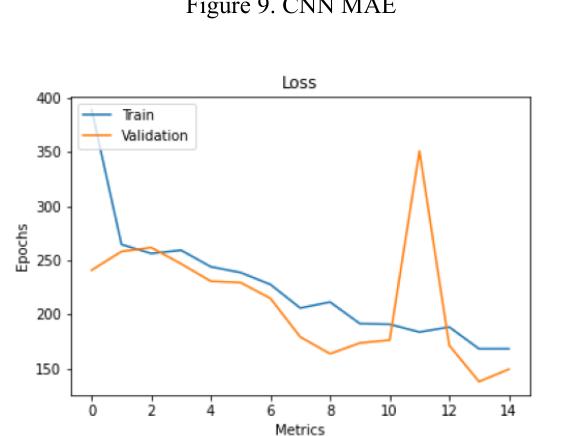
Figure 9. CNN MAE